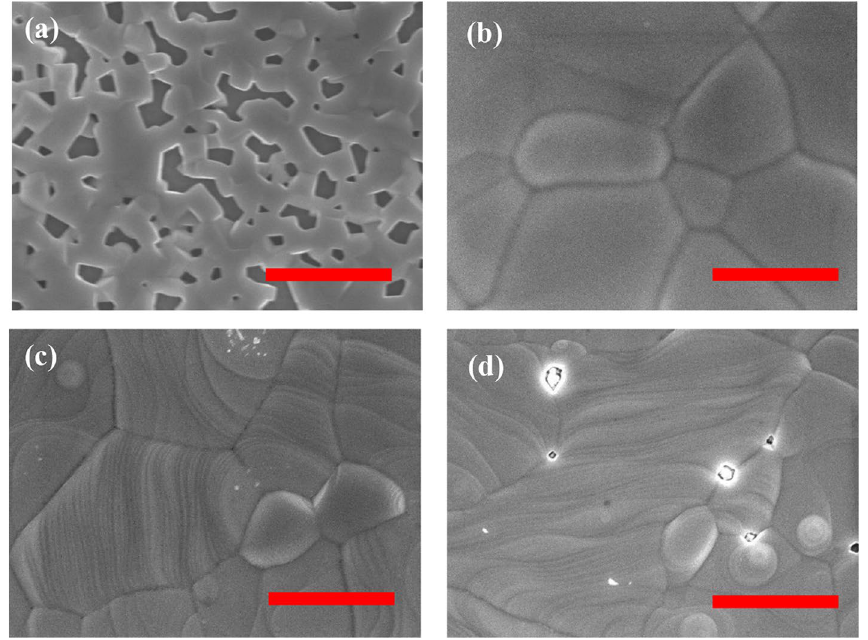
Figure 3. Low and high magnification SEM images of ( a , b ) pristine perovskite, ( c , d ) 1% AgI, ( e , f ) 2% AgI, ( g , h ) 5% AgI. Scale bars is 1 µm.